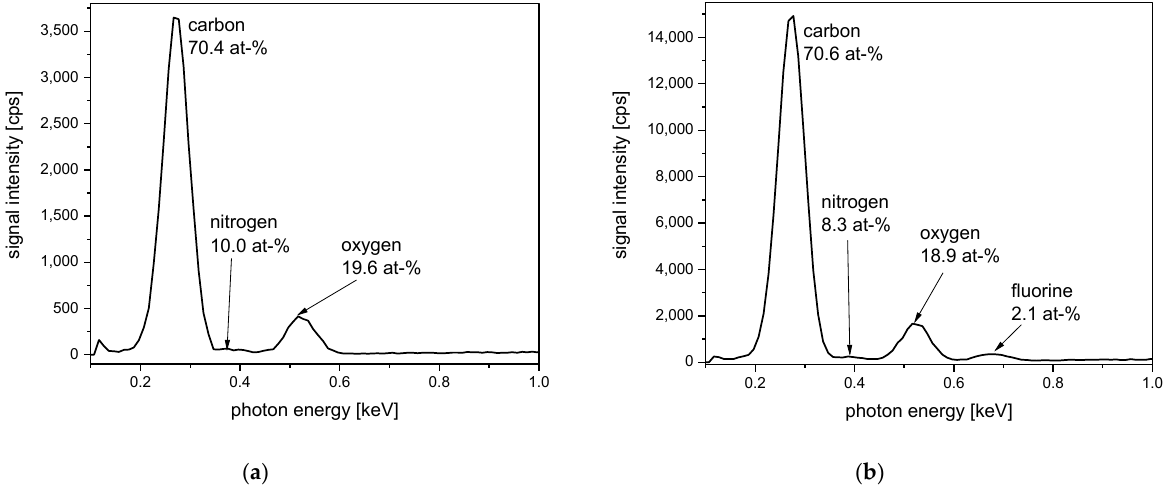
Figure 18. EDS spectra of different flame-retardant polyimide PI fiber materials: ( a ) PI fiber material